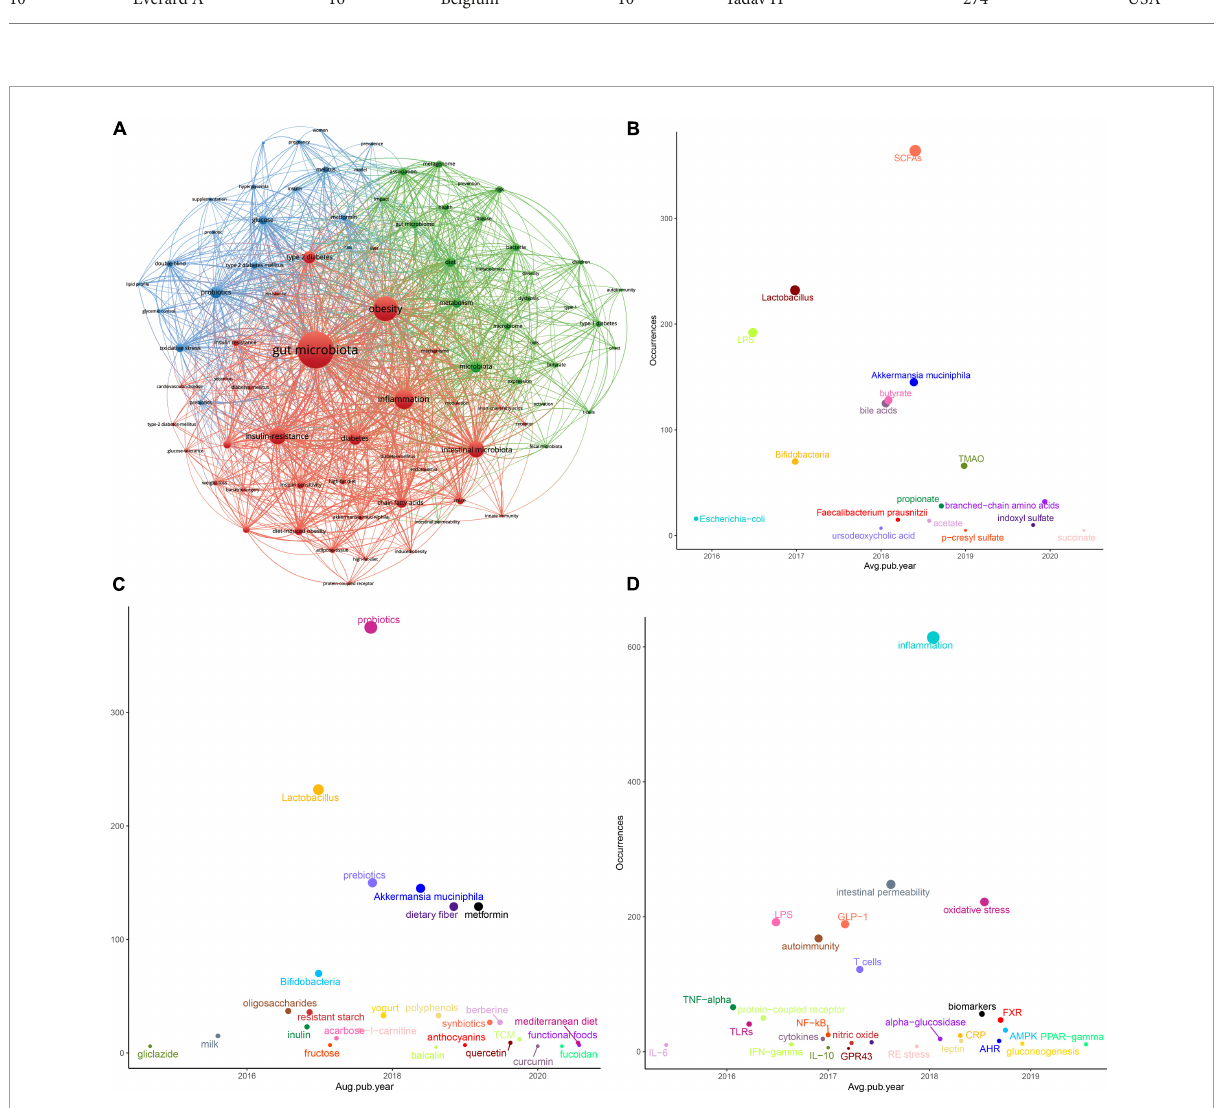
FIGURE5 Keywords analysis in the “gut microbiota and diabetes” area. (A) Clustering analysis of high frequency keywords. (B) Coordinate diagram of frequency occurrence of the intestinal bacteria (and their metabolites). (C) Coordinate diagram of frequency occurrence of interventions. (D) Coordinate diagram of frequency occurrence of molecular